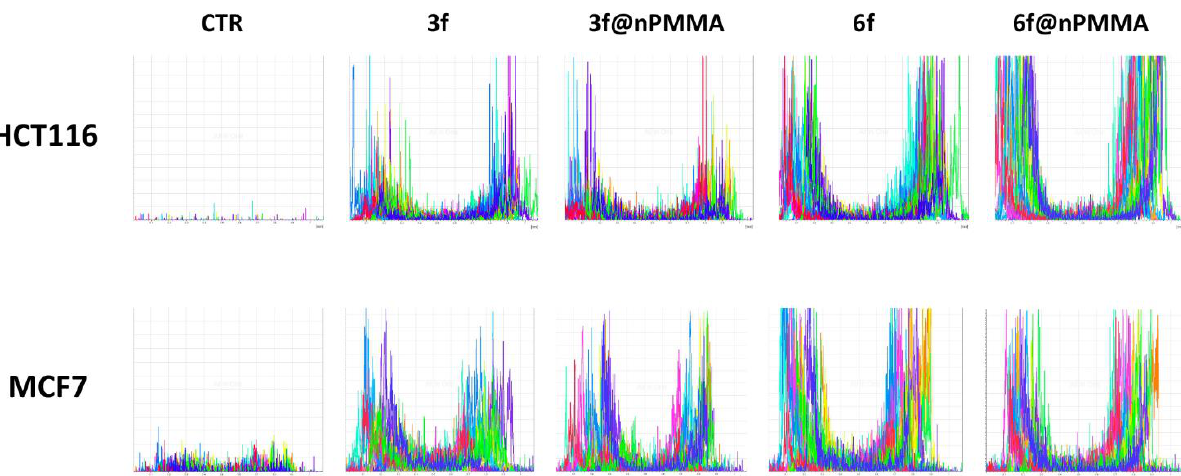
Figure 10. Penetration of 3f, 3f@nPMMA, 6f and 6f@nPMMA (100 nM) in HCT116 and MCF7 spheroids after 24 h incubation. The histograms represent the analysis of distribution and intensity of fluorescence in the PSs in 15 different randomly traced diameters in the equatorial planes.